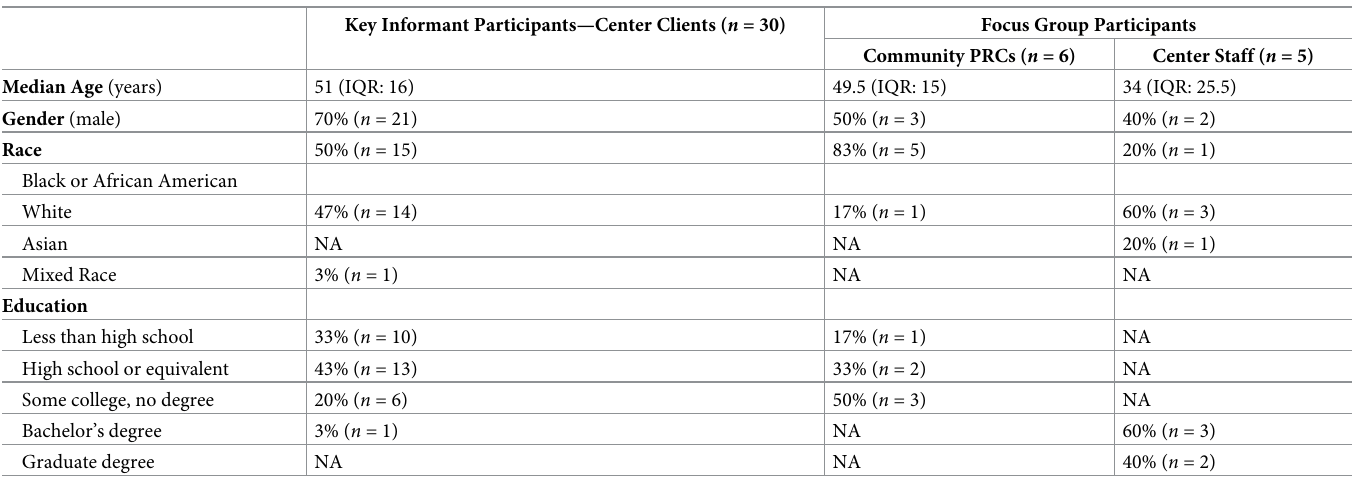
Table 1. Demographic characteristics of qualitative participants. Key Informant Participants—Center Clients ( n = 30)